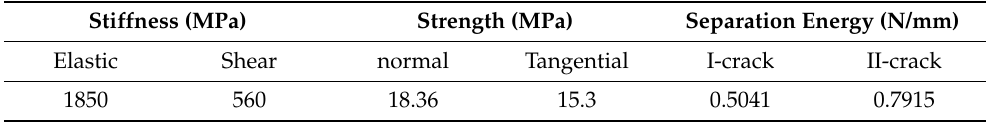
Table 1. Properties of the adhesive Araldite 2015 for CZM